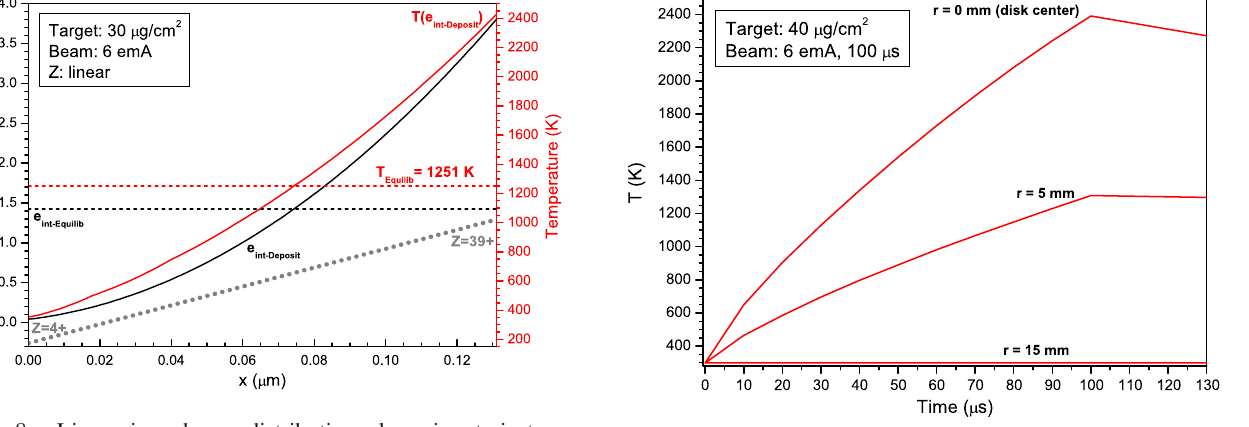
FIG. 10. Same as in Fig. 3, but for foil thickness ¼ 40 μ g = cm 2 and a uniform charge distribution of 40 þ .